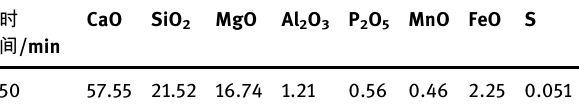
Table 7: Composition of converter slag after reduction ( wt% ) 时 间 /min